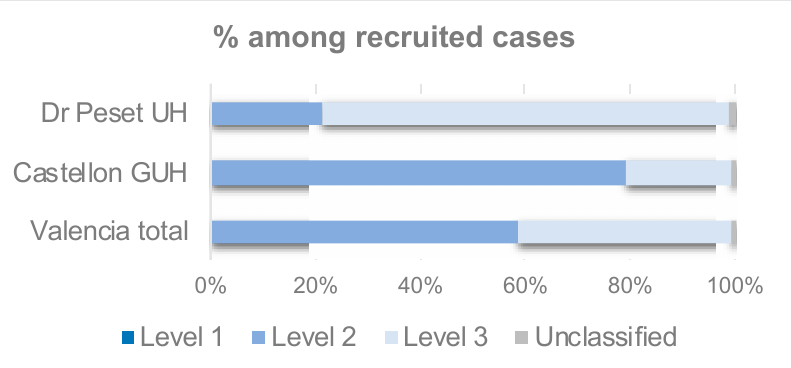
Figure 4. Maternal immunization: Bar chart showing the percentage of the vaccinated mothers from recruited cases classified by GAIA level of diagnostic certainty.